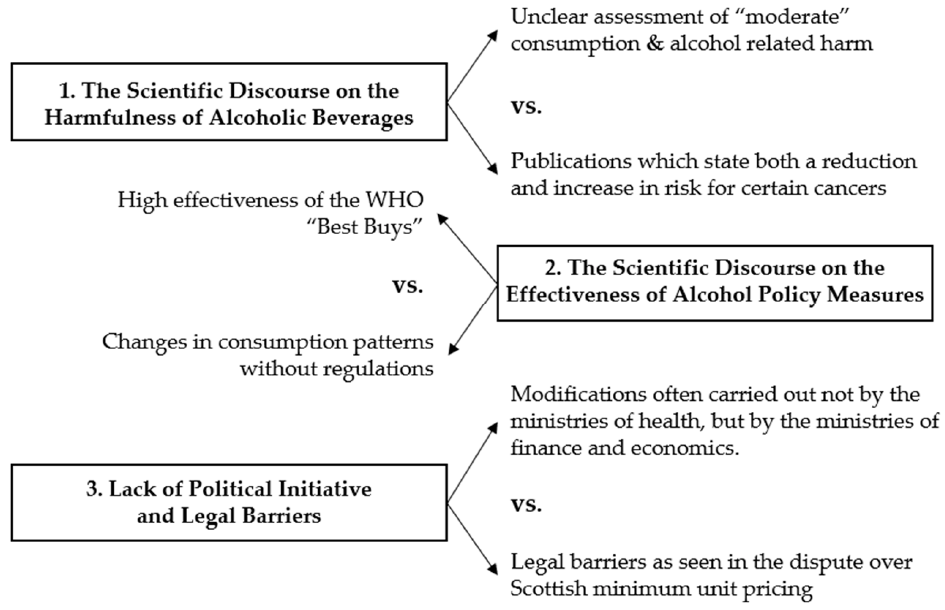
Figure 1. Summary of Limiting Influences on European Alcohol Policy.